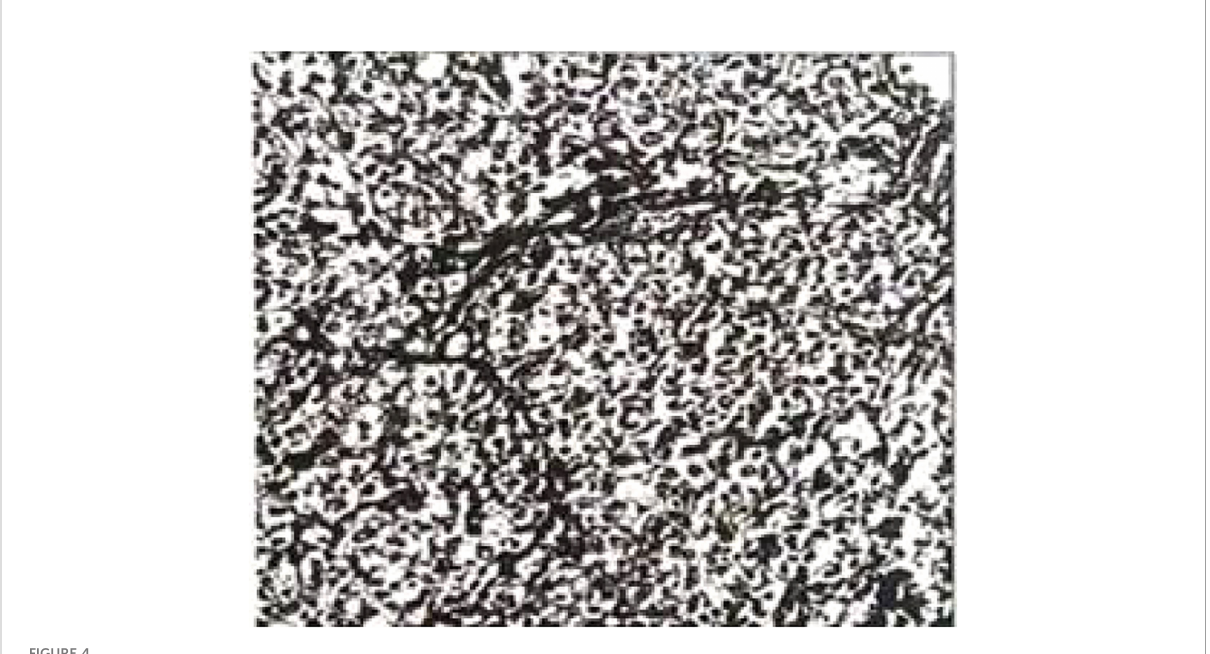
FIGURE 4 Postoperative pathology